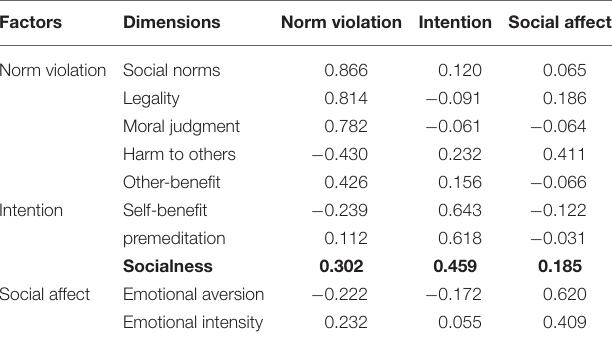
TABLE 4 | The reduced questionnaire factors based on exploratory factor analysis.